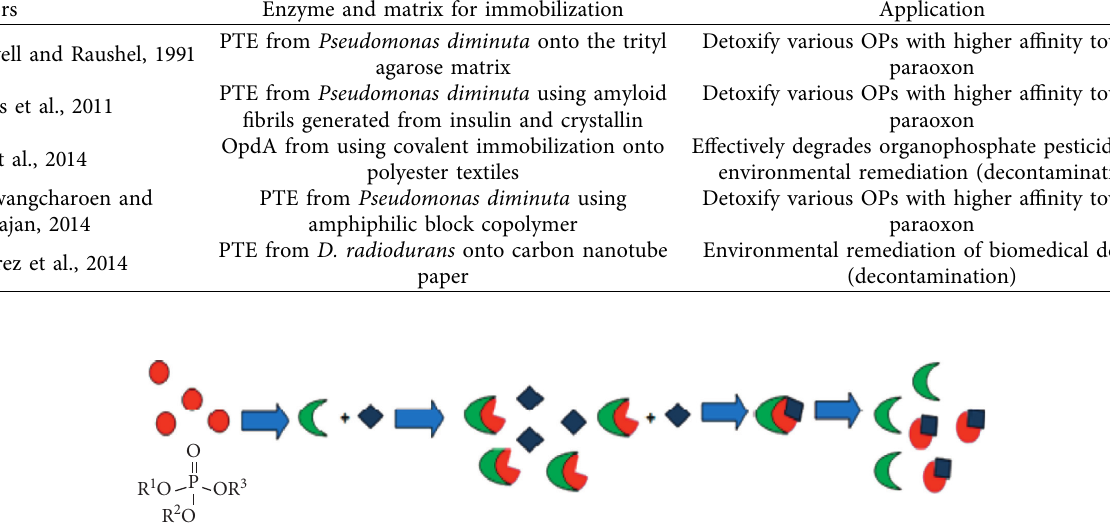
Table 1: Validated decontamination and detoxification approaches using enzymes.